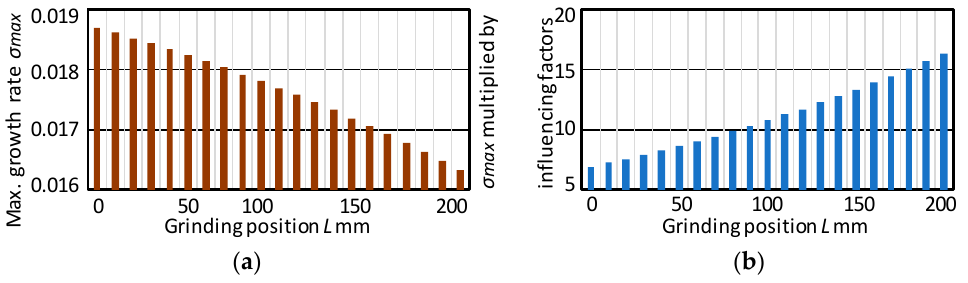
Figure 6. RSI calculation. RSI = 11.1. ( a ) Max. growth rate σ max ; ( b ) σ max multiplied by influencing factors. Conditions: dw = 25 mm, b = 30 mm; dr = 300 mm; γ 0 = 6.75°, Nr = 50 rpm, Lg = 200 mm, Δ L = 10 mm, N = 20.